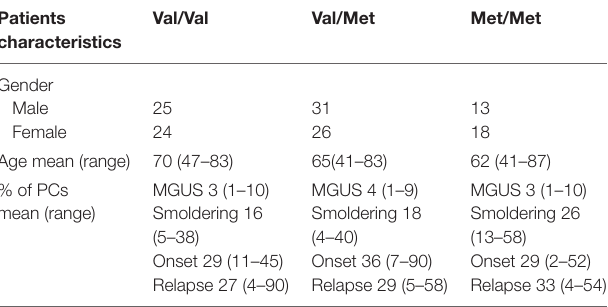
TaBle 2 | Patient characteristics. Patients characteristics